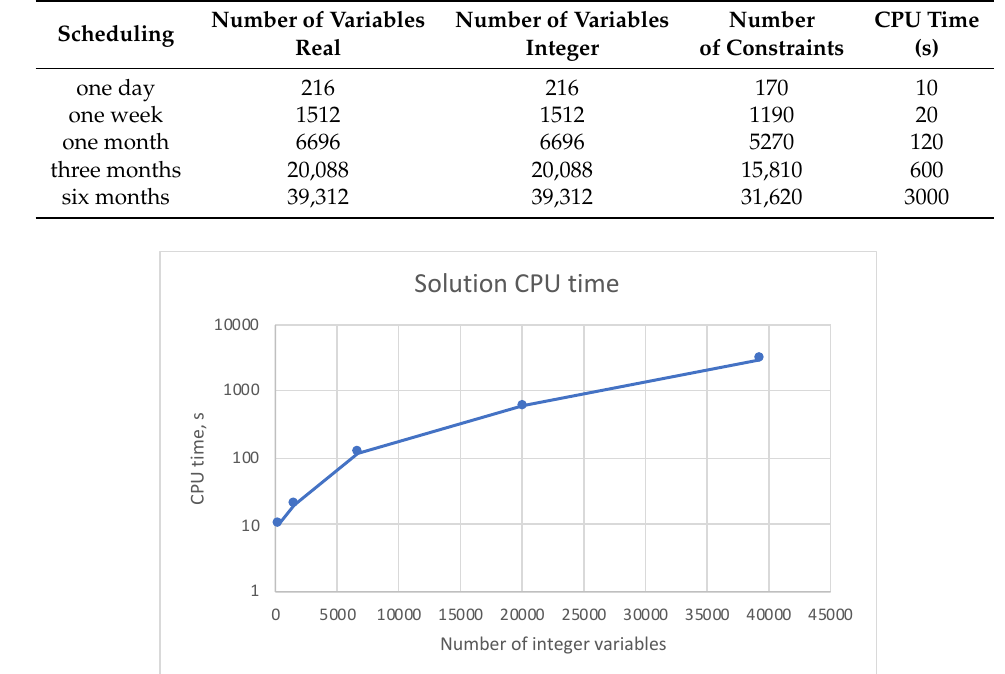
Table 3. CPU time on one-hour time scale discretisation.